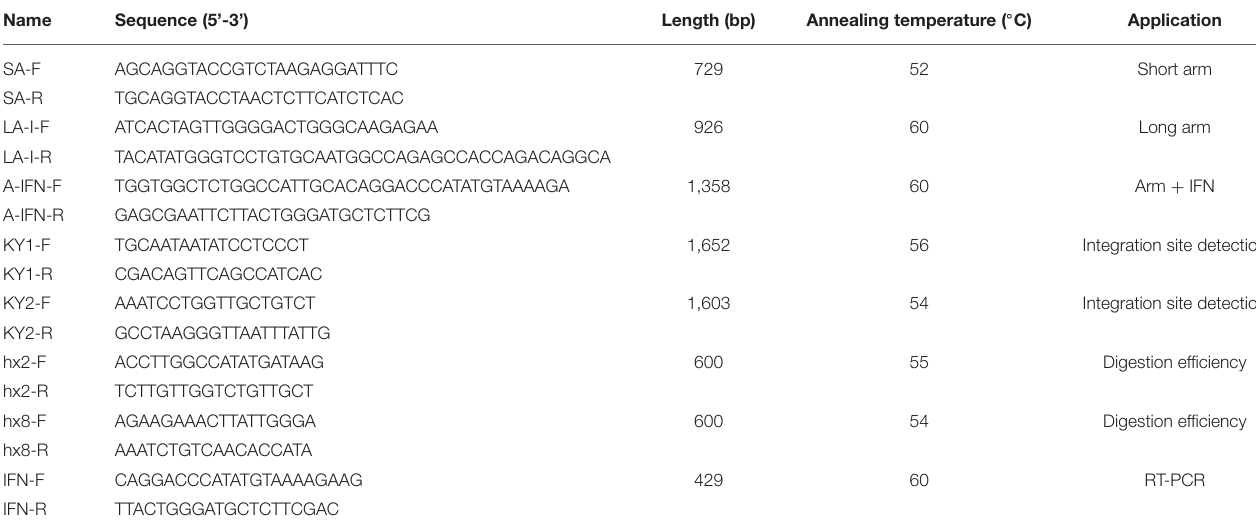
TABLE 1 | The primers that used in this